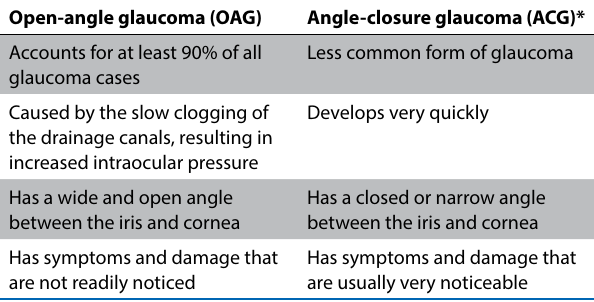
Table I: Major types of glaucoma